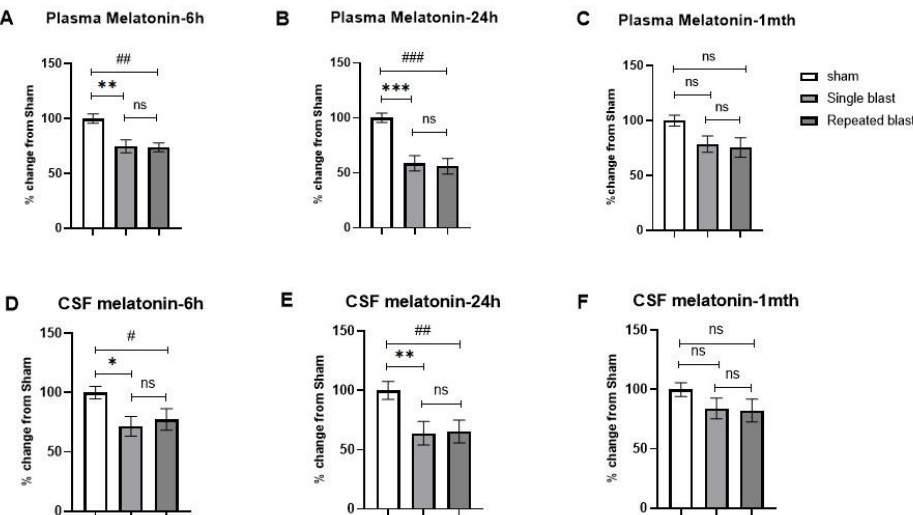
Figure 2. Effect of single and repeated blast exposure on plasma and CSF melatonin concentrations measured at night in SD rats. Plasma melatonin concentrations at ( A ) 6 h, ( B ) 24 h, and ( C ) 1 month after blast injury. CSF melatonin concentrations at ( D ) 6 h, ( E ) 24 h, and ( F ) 1 month after blast injury. Results are expressed as means ± SEM (n = 4 – 6); *** p < 0.001, ** p < 0.01, and * p < 0.05 for sham vs. single blast group; ### p < 0.001, ## p < 0.01, and # p < 0.05 for sham vs. repeated blast group; ns — not significant.